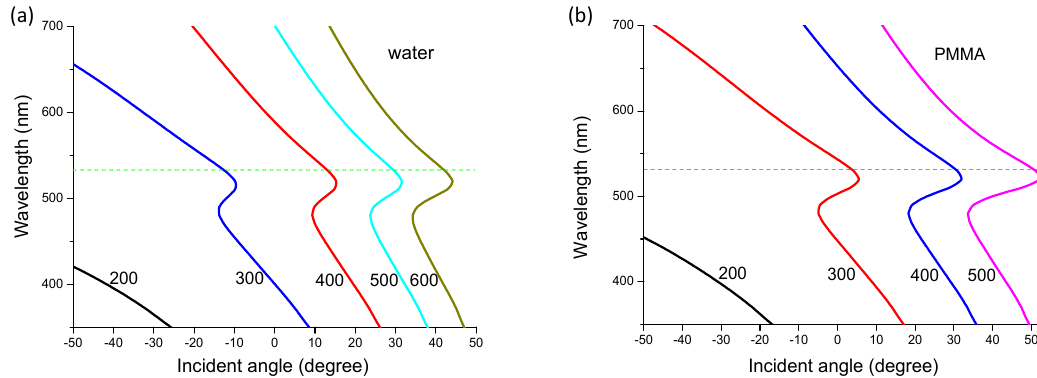
Figure 8. Plot of dispersion relation on ( a ) gold–water and ( b ) gold–PMMA interfaces. The numbers next to the curves are the grating period in nanometer. The green horizontal dashed line indicates the excitation wavelength of 532 nm.